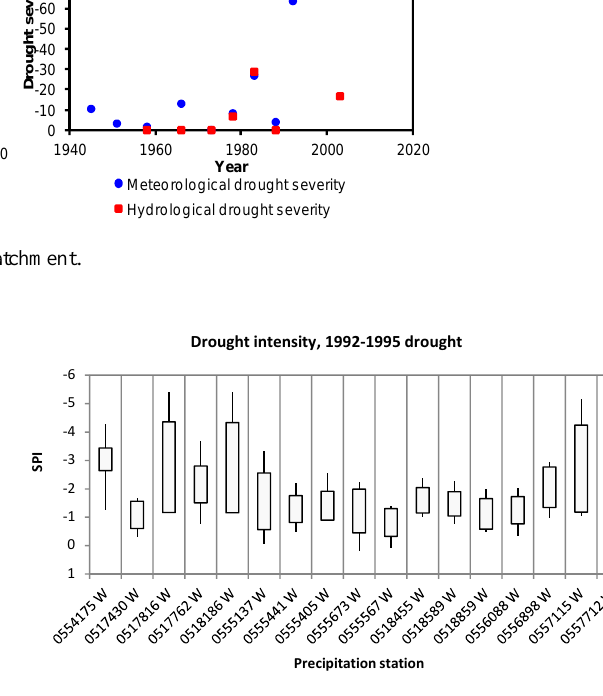
Figure 6. Meteorological drought intensity during the 1992–1995